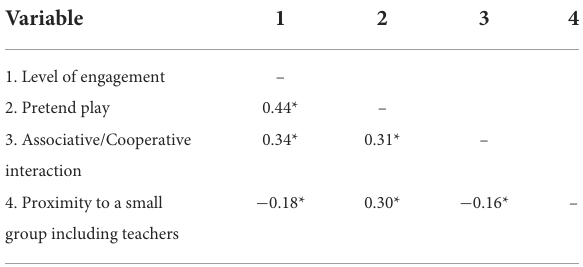
TABLE 2 Pearson correlations among cluster variables ( n =